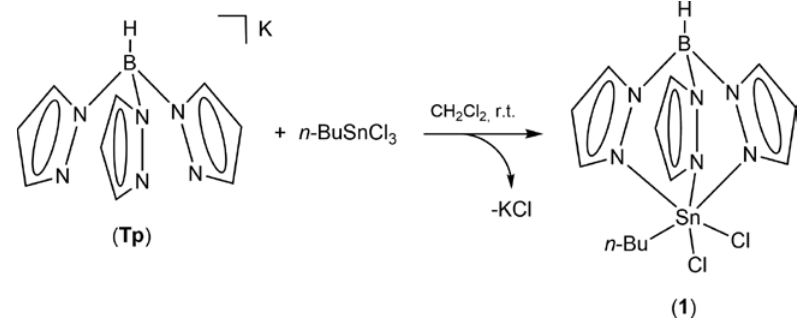
( n -Bu)·toluene ( 1 ) showing 40% probability ellipsoids and the crystallographic numbering scheme 2